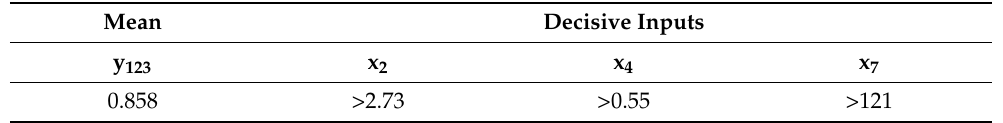
Table 5. The most decisive inputs and their optimal values for the favorable y 123 value, derived from RT analysis. The data ranges correspond to the white nodes in Figure 8.